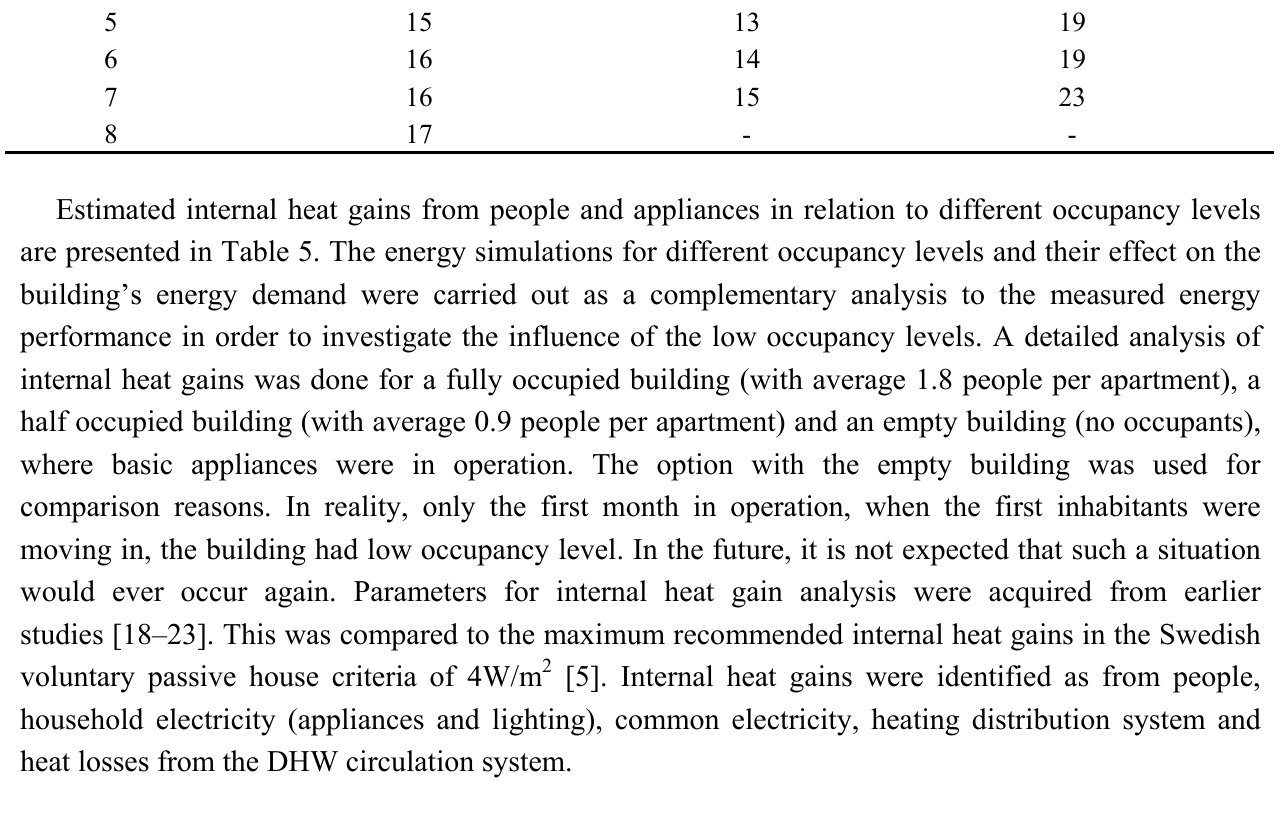
Table 5. Internal heat gains used for energy